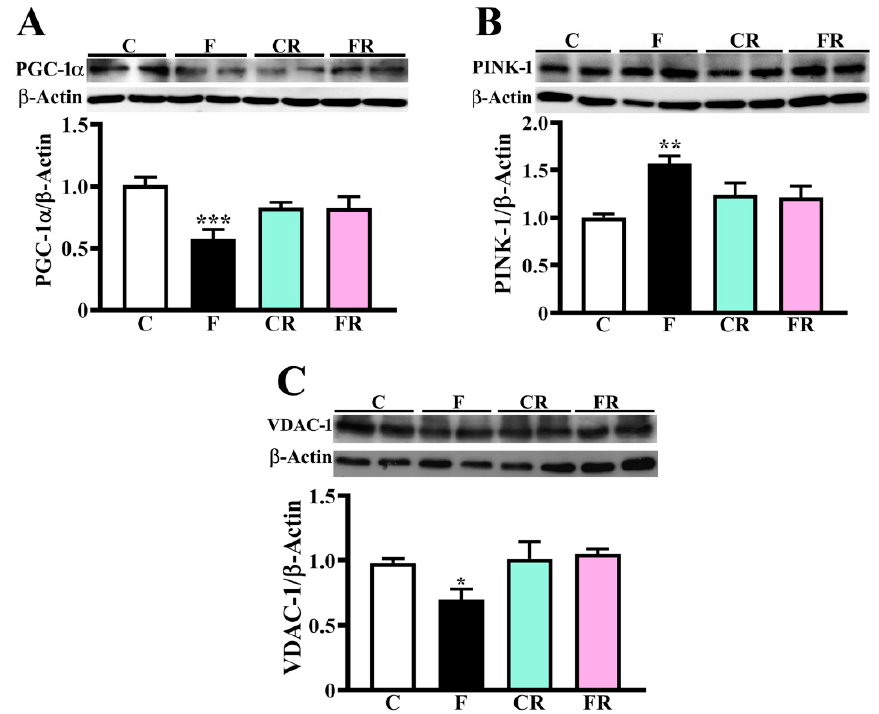
Figure 4. PGC-1 α , PINK-1 and VDAC-1 levels in rat hypothalamus. PGC-1 α ( A ), PINK-1 ( B ), and VDAC-1 ( C ) were quantified in protein extracts from the hypothalamus of control adolescent (C), fructose-fed adolescent (F), young-adult control rescued (CR), young-adult fructose-rescued (FR) rats. Samples were analyzed by 10% (PGC-1 α ) or 12.5% (PINK-1, VDAC-1) SDS-PAGE and western blotting. After detection of immunocomplexes [by rabbit anti-PGC-1 α and GAR-HRP IgGs ( A ), or mouse anti-PINK-1 and GAM-HRP IgGs ( B ), or mouse anti-VDAC-1 and GAM-HRP IgGs ( C )], the membranes were stripped and treated with anti- β -actin as loading control. Data shown are means ± SEM of eight animals from each group * p < 0.05, ** p < 0.01, *** p < 0.001 versus C (one-way Anova followed by Bonferroni post-test).